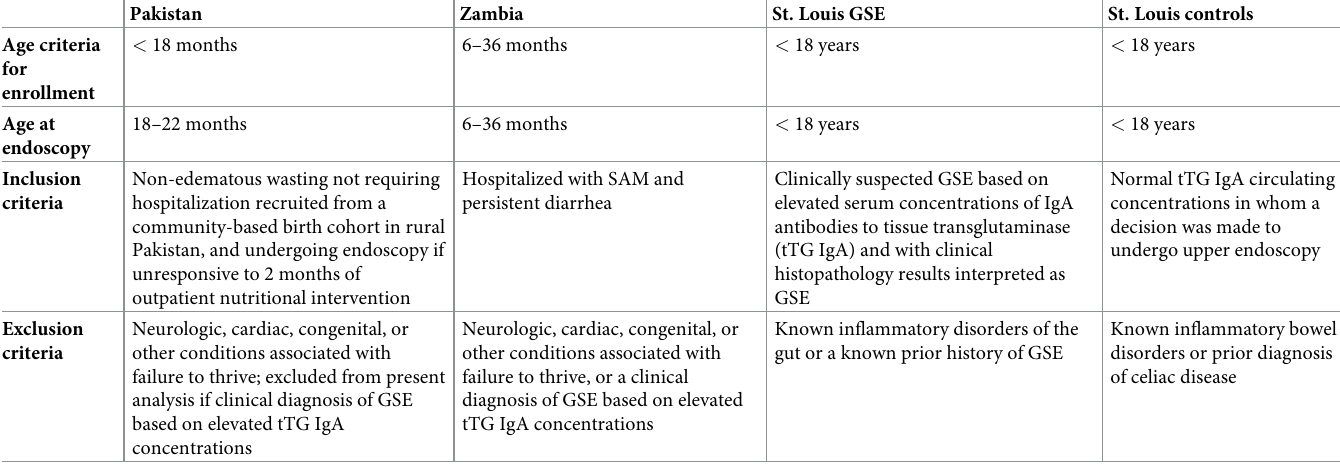
Table 1. Cohort inclusion and exclusion